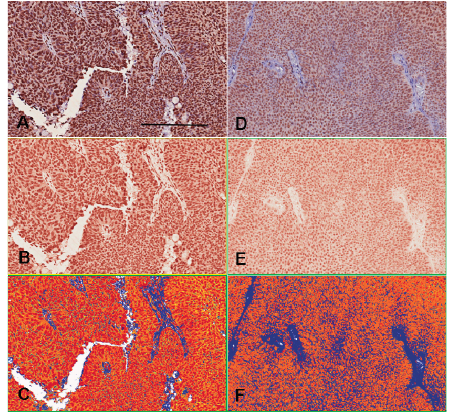
Figure 3. Immunohistochemical intensity representated as H-score by imaging software counts. The A – C photography are the sample 1. The D – F photography are the sample